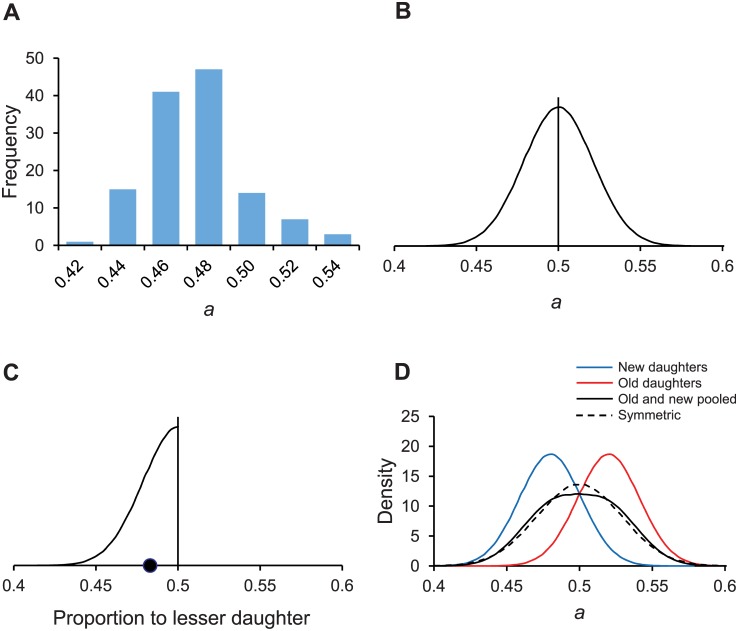
Distributions of the asymmetry coefficient a.The value of a represents the proportion of damage partitioned by a mother bacterium to its new daughter. Asymmetry requires that a < ½. If a = ½, the partitioning is symmetrical. Distributions are illustrative representations except for (A), which was derived from the experiments of Stewart et al. [9]. (A) Stochastic variation for observed values of a estimated from experimental E. coli data. Distribution mean = .4845, variance σS
2 = .0004557, and sample size n = 128. (B) Distribution of a when the partitioning of damage is stochastic but symmetrical with a mean of ½. A Gaussian distribution with a variance of σS
2 = .0004557 is assumed for illustration. (C) Distribution of the proportion of damage allocated to the daughter that gets less damage when partitioning is stochastic but symmetrical. Because symmetrical partitioning is random with respect to whether a daughter is old or new, polarity can be ignored and all the daughters can be re-categorized into ones that get less and ones that get more damage. If only the lesser daughters are considered, the resulting distribution is the half- or folded normal of the Fig 3B distribution. The mean of the half-normal is ½—√(σS
2 • 2 / 3.141593…), which equals .483 (●). (D) Gaussian distributions representing four populations: a of new daughters (mean = .48; var = σS
2 = .00046; a of old daughters (mean = 1 –.48 = .52; var = σS
2 = .00046); a population made by pooling the new and old daughters; and daughters produced by a stochastic but symmetric mother where the variance is increased to σS
2 + D
2/4 = .00046 + .00042/4 = .00086 and mean = ½.